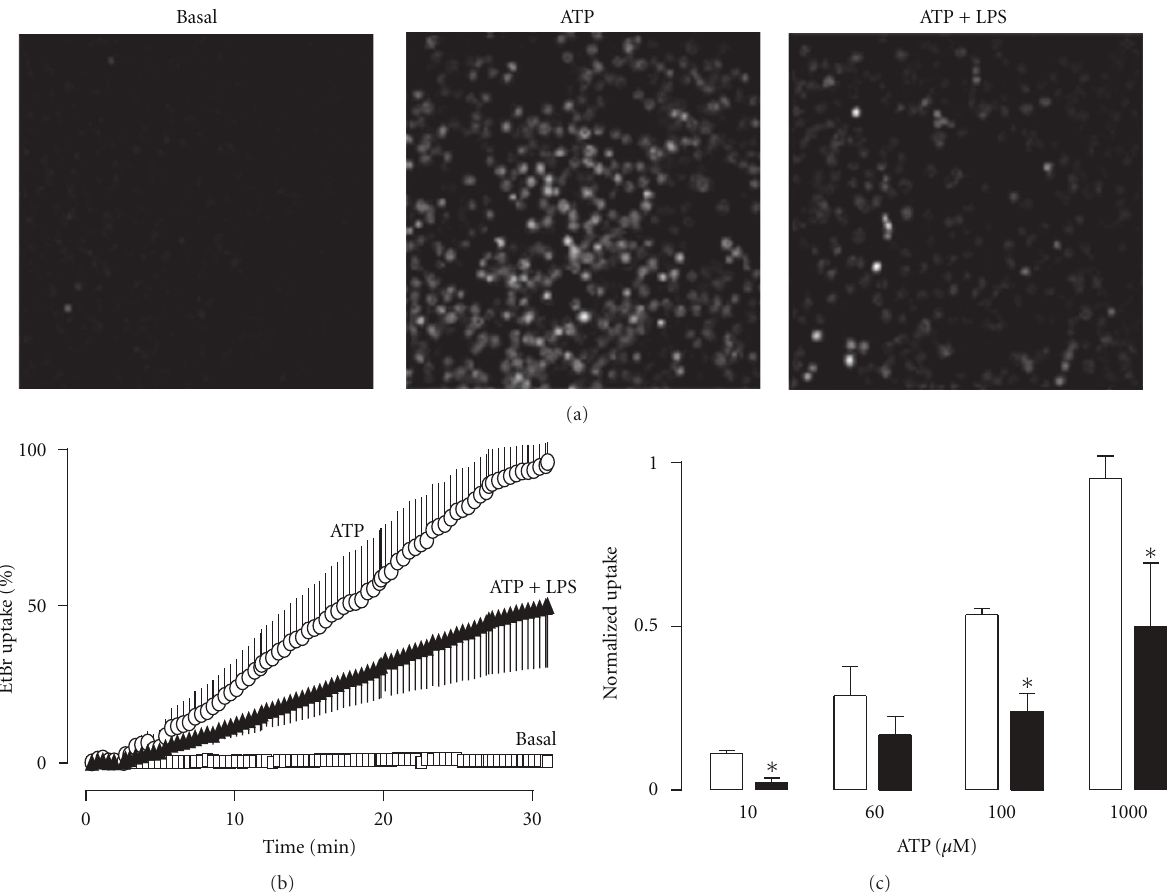
Figure 4: LPS inhibits the ATP-induced EtBr uptake on P2X7R-HEK293 cells. (a) Representative images obtained from EtBr uptake protocols in nontreated cells (basal) after 30min of treatment with 1mM ATP alone (ATP) or plus 1 μ g/mL LPS (ATP + LPS). (b) Summary of the time-dependent EtBr incorporation obtained with 1 mM ATP alone (open circles) or plus LPS (closed triangles); n = 4. (c) LPS inhibition of ATP-induced EtBr uptake at di ff erent ATP concentrations ( P < 0 . 05, unpaired t -test; n = 3-4). Experiments were performed in the presence of 1%